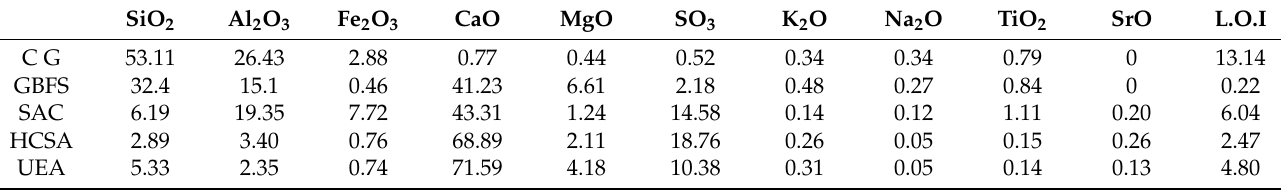
Table 1. Chemical composition of raw materials and additives (wt.%).